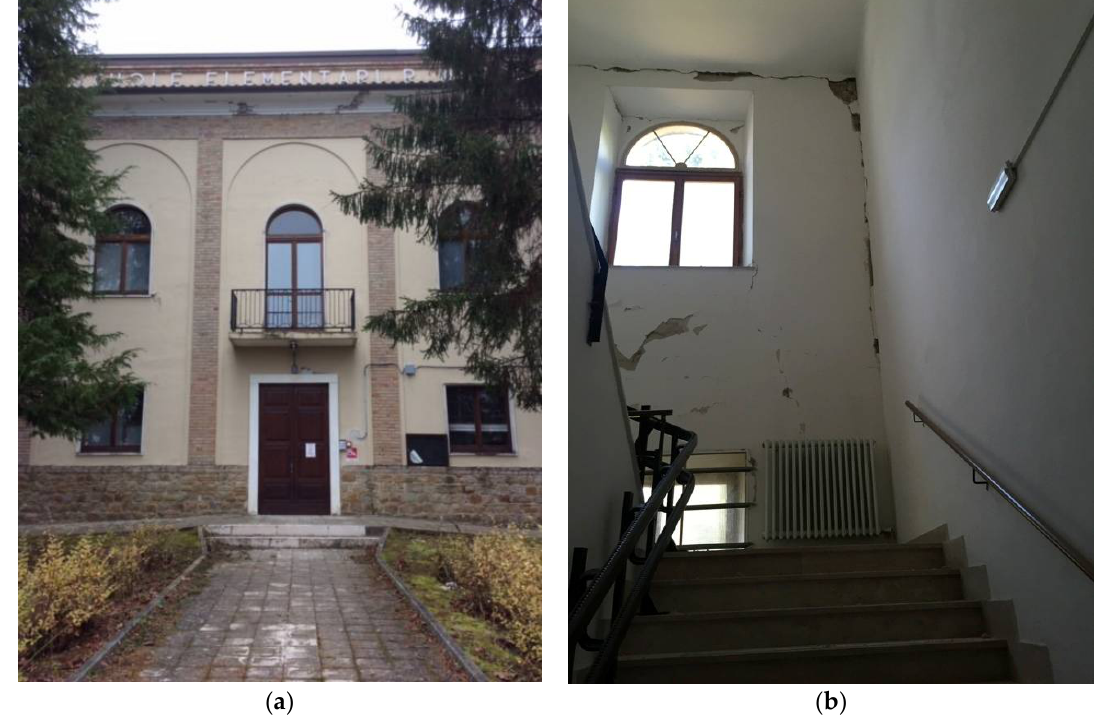
Figure 2. Gualdo, the school building after the earthquakes in 2016: ( a ) The entrance with the main facade; ( b ) Internal view with the stairway to the first floor (November/December 2016, photo